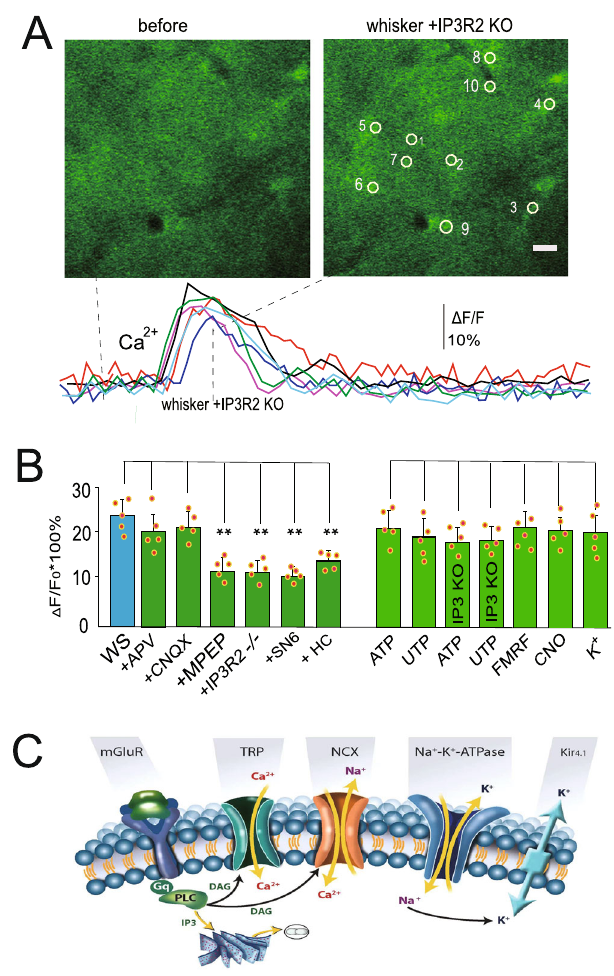
Fig. 5 | Small Ca 2+ transients during sleep are derived from multiple sources of Ca 2+ . A Representative photomicrographs showing that whisker stimulation induced small Ca 2+ transients in IP 3 R 2 knockout mice, as illustrated by increased fl uorescenceintensity. The scalebar is10 µ m. The lowerpanel shows typical traces of Ca 2+ transients. B Statistical data show the comparison of whisker stimulation- induced changes in Ca 2+ transients with agonists and in IP3R 2 knockout mice with differentmanipulationsofblockers(** P <0.001,one-wayANOVA,F(6,232)=54.57; spotsshowtheaveragedvalueineachmouse, n =5miceineachgroup,thedataare shown as the mean±SD). C A schematic diagram shows the intrinsic ion channels involved in the oscillation. Whisker stimulation-induced glutamate release from neurons affects astrocytes via mGluR (metabotropic glutamate receptor), and mGluR activates PLC (phospholipase C) to release IP3 (inositol trisphosphate) and DAG (diacylglycerol), which in turn activate TRP channels (transient receptor potential ion channels) and NCX (the Na + /Ca 2+ exchanger) channels and thus Ca 2+ in fl ux. ATP, UTP, and FMRF in Mrg mice can also activate Gq receptors (G protein- coupled receptors) to activate PLC and release IP3 and DAG, thus inducing Ca 2+ in fl ux via TRP channels and NCX channels. Note: Kir4.1, an inwardly rectifying potassium (Kir)